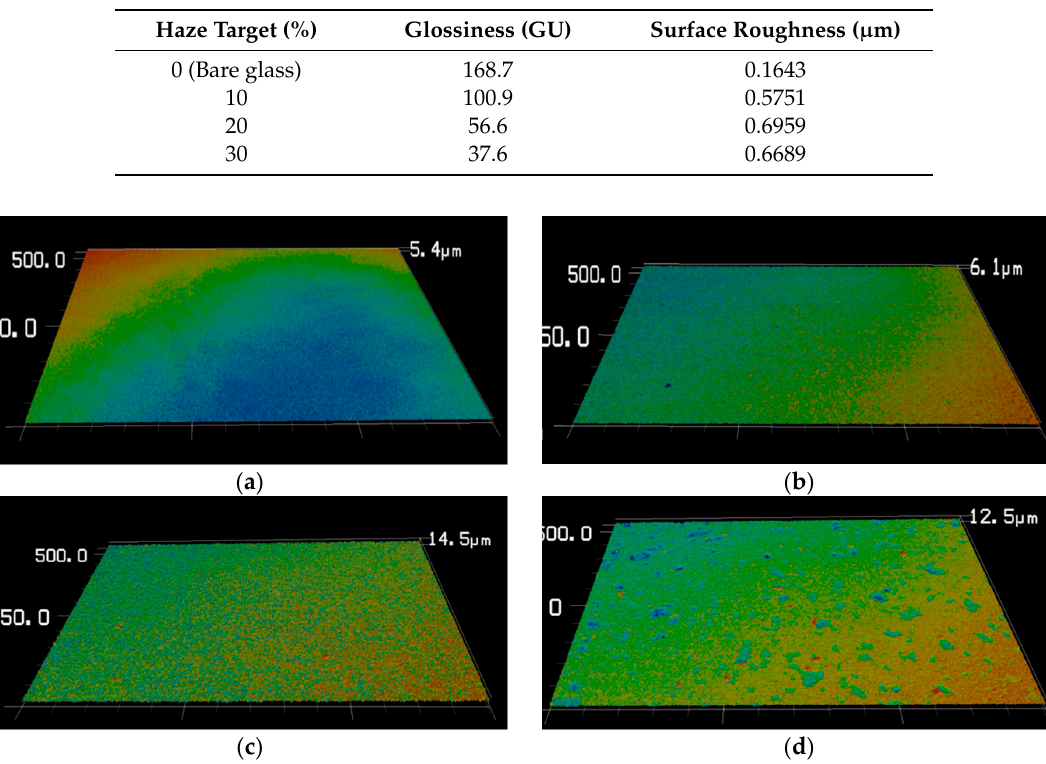
Figure 9. RA measurement surface: ( a ) Bare glass; ( b ) glass with 10% haze target; ( c ) glass with 20% haze target; ( d ) glass with 30% haze target;.